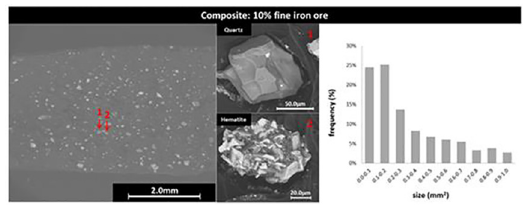
Figure 2. SEM and BSE images of the fractured surface of composite with 10% of fine iron ore, and histogram of the average size of the particles.